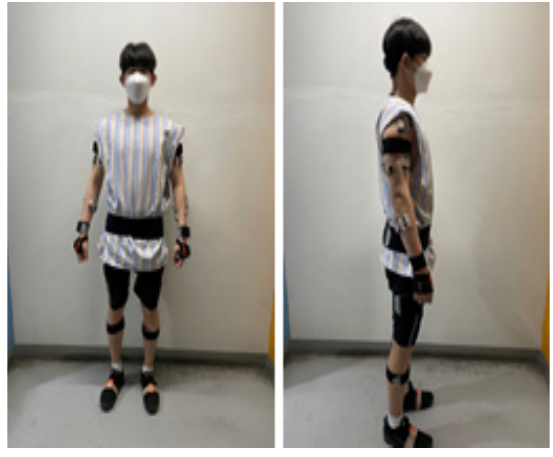
Figure 4. Locations of motion-capture sensor attachments.